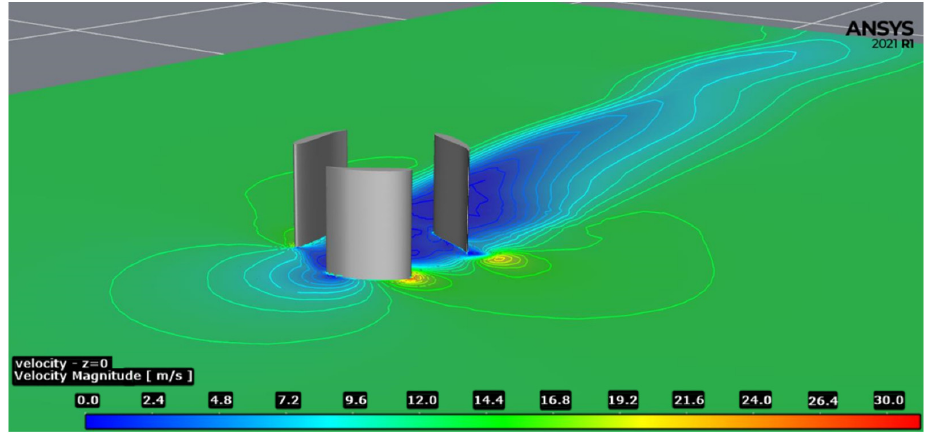
Figure 9. Isometric view of velocity contour for wind speed 14 m/s at TSR of 0.7.